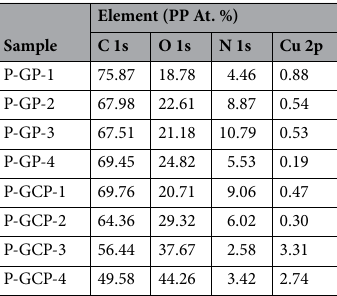
Element (PP At. Sample